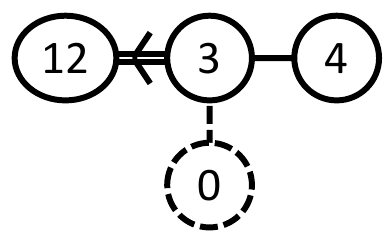
Figure 5 . The b B 3 Dynkin